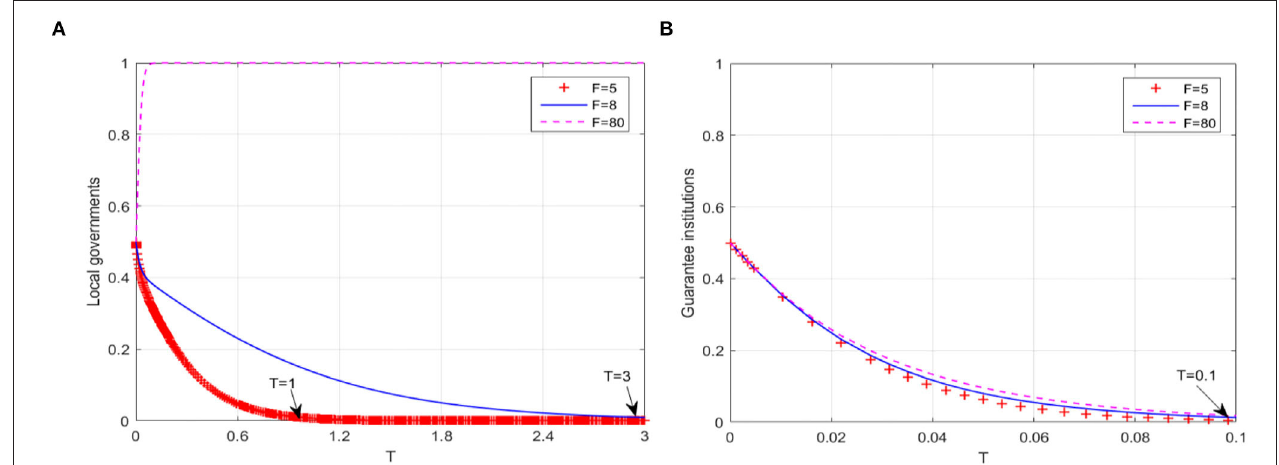
FIGURE 2 | The breakthrough effect of path 1 on low-level equilibrium. (A) Local governments (B) Guarantee institutions.